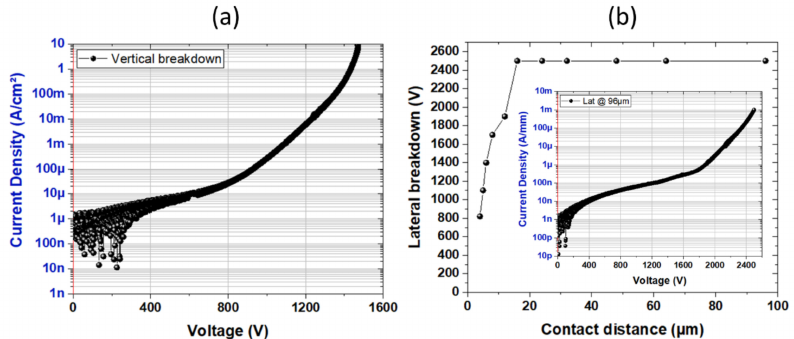
Figure 2. Vertical breakdown voltage ( a ) and lateral floating breakdown voltage as a function of the contact distances ( b ) and the p-GaN/AlGaN/GaN HEMT on Si at room